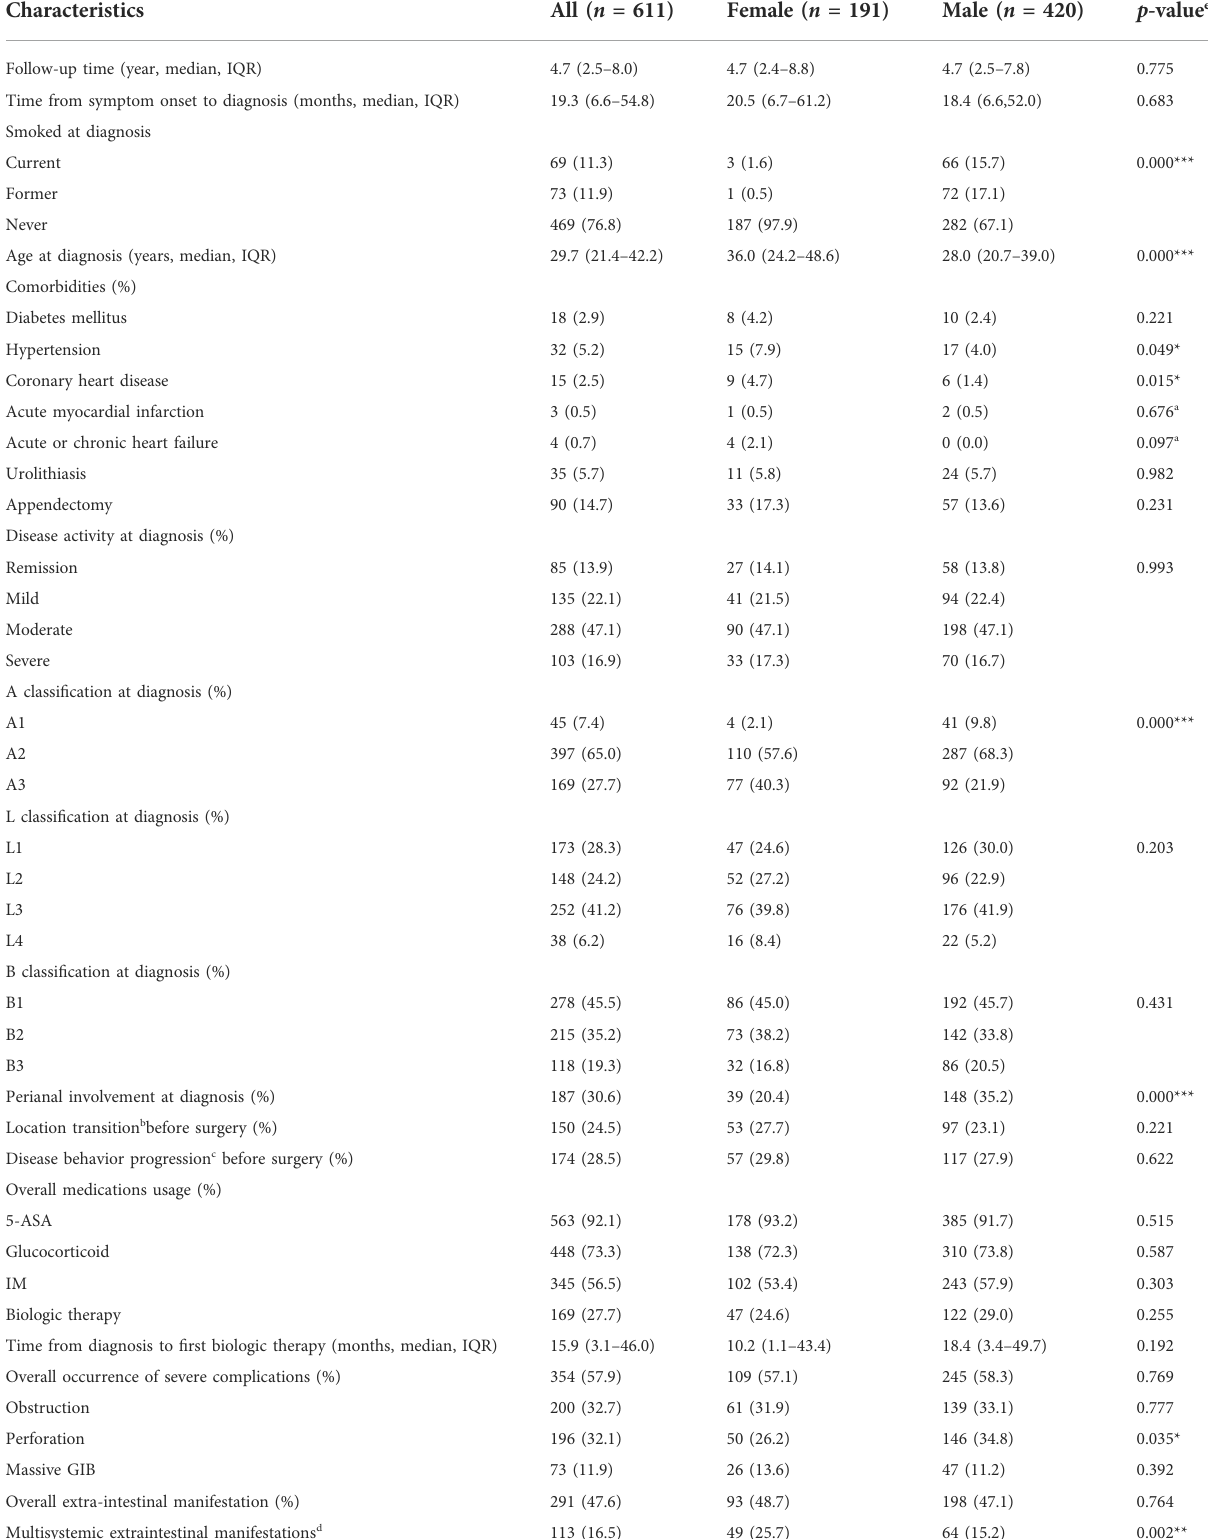
TABLE 1 Demographic and clinical characteristics of female and male CD patients at diagnosis and during follow-up.